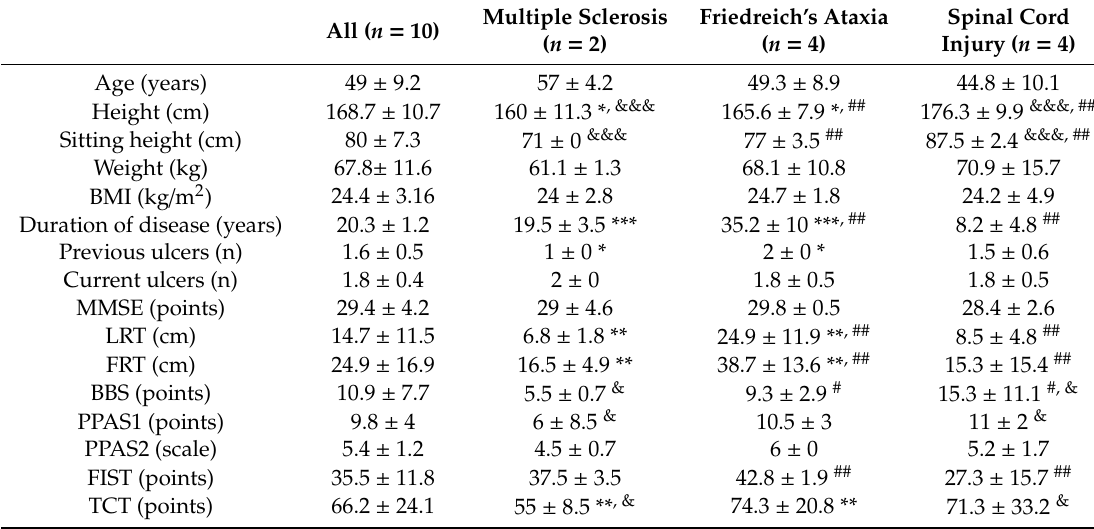
Table 1. Descriptive statistics of the sample and by groups.